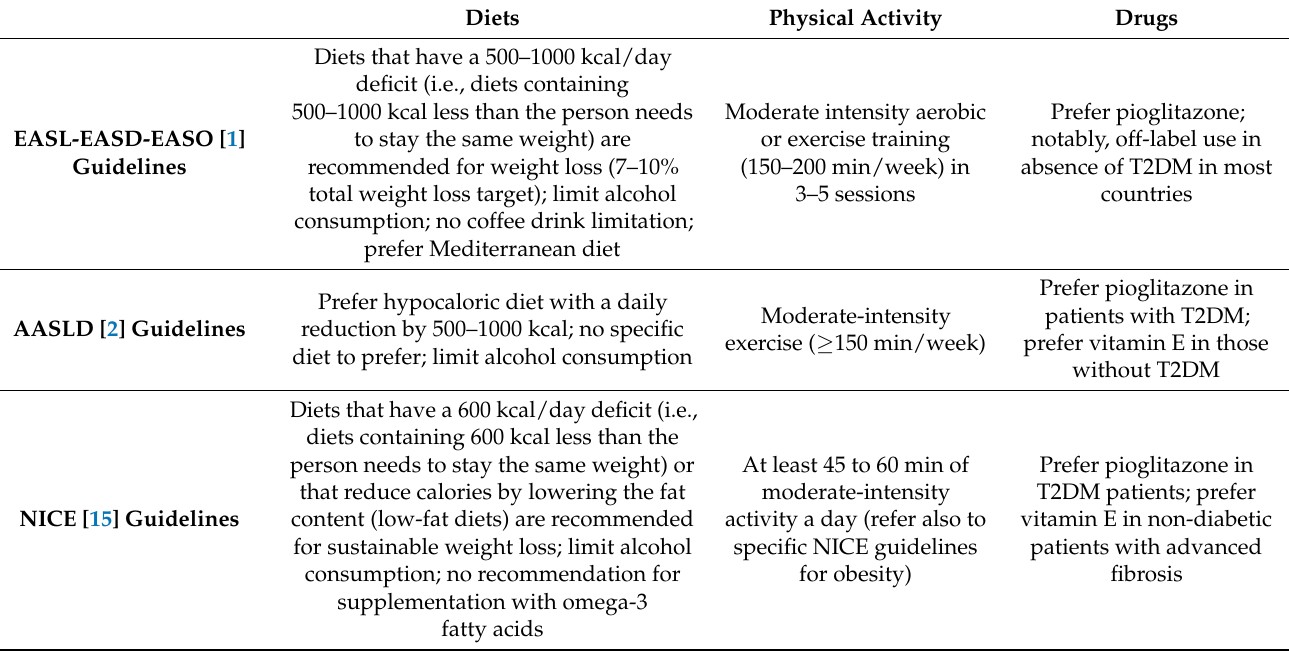
EASL-EASD-EASO: European Association for the Study of the Liver (EASL)—European Association for the Study of Diabetes (EASD)— European Association for the Study of Obesity (EASO); AASLD: American Association for the Study of Liver Diseases; NICE: National Institute for Health and Care Excellence; T2DM: type 2 diabetes